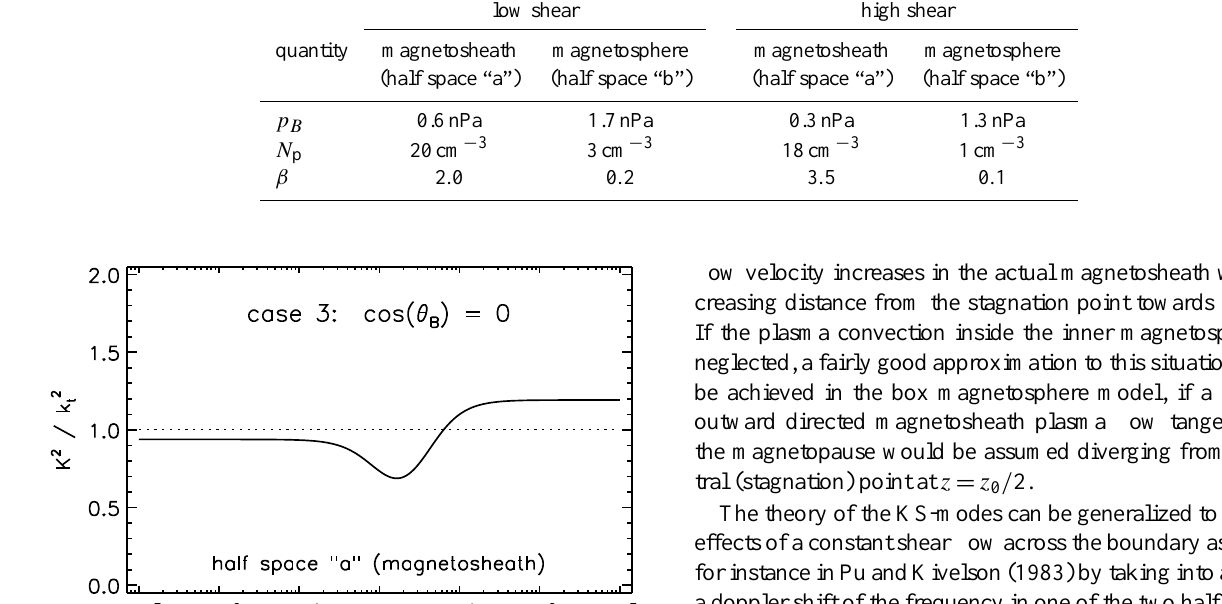
Table 1. Typical values of the magnetic pressure p B , the proton number density N p and the quotient of thermal and magnetic pressures β on both sides of the magnetopause for the low and high shear situations. Taken from the Figs. 9 and 10 of Phan et al. (1994). low shear high shear magnetosheath magnetosphere